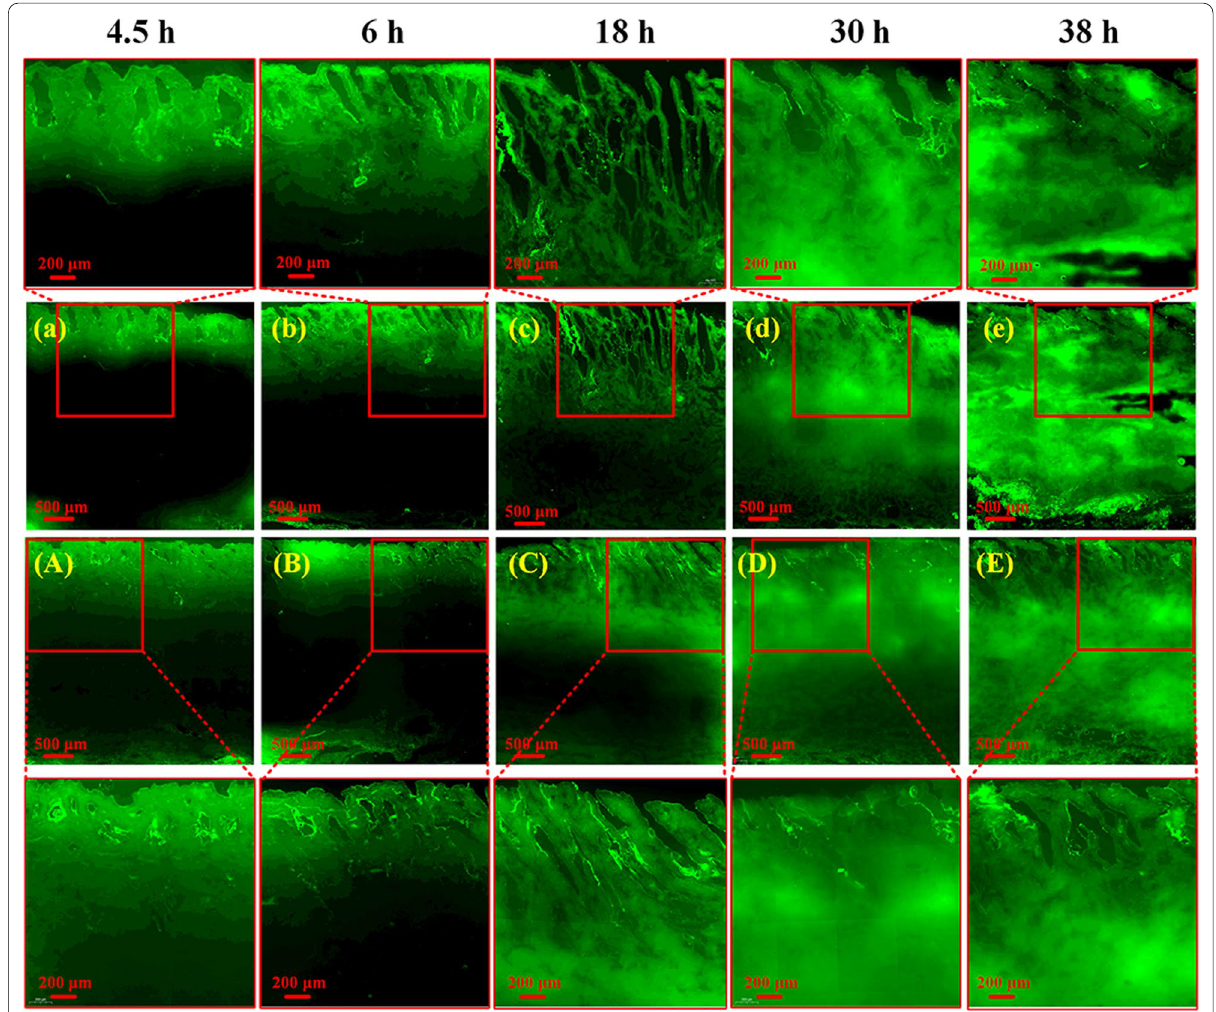
Fig. 4 Fluorescence scans of the cross-section of bovine hides during one-pot beamhouse with the processes of KCl/FITC-disapse ( a – f ) and [AMIm] Cl/FITC-dispase ( A – F